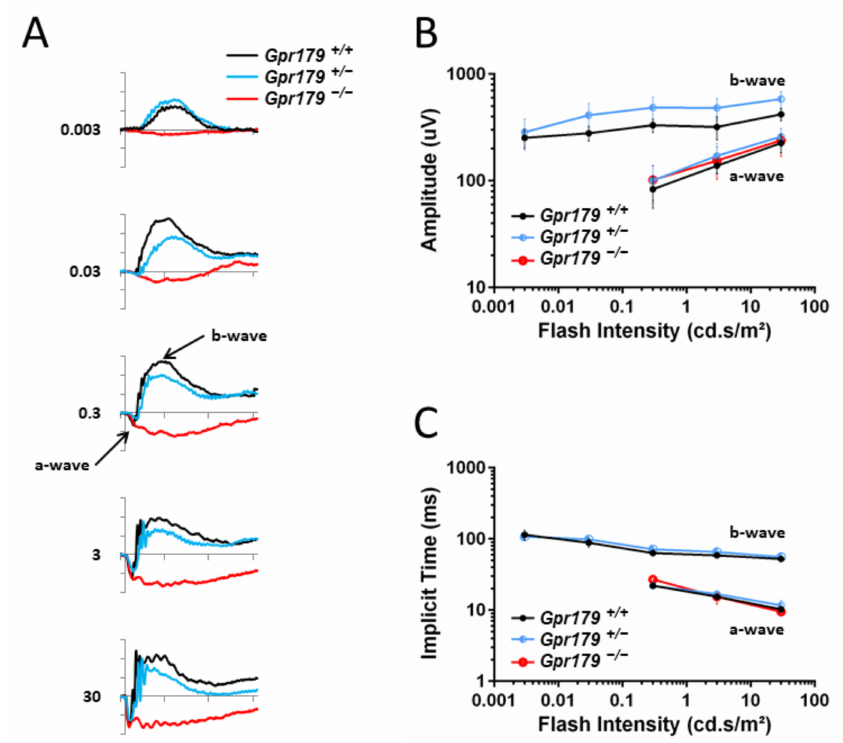
Figure 3. Scotopic electroretinogram, (ERG) responses. Dark-adapted ERG series were obtained from 10 Gpr179 +/+ (black line), 12 Gpr179 +/ − (blue line), and 10 Gpr179 − / − (red line) littermates. ( A ) Representative waveforms as a function of stimulation intensity. The scale marks indicate 100 ms (time in abscissa) and 200 µ V (amplitude in ordinate). Values to the left of the waveforms indicate stimulation flash intensity in cd.s/m 2 . a-waves and b-waves are depicted with arrows for the Gpr179 +/+ mouse recording at 0.3 cd.s/m 2 . Amplitude ( B ) and implicit time ( C ) of the major components of the dark-adapted ERG with increasing flash intensity. The b-wave component is absent in Gpr179 − / − mice, and therefore these data are not